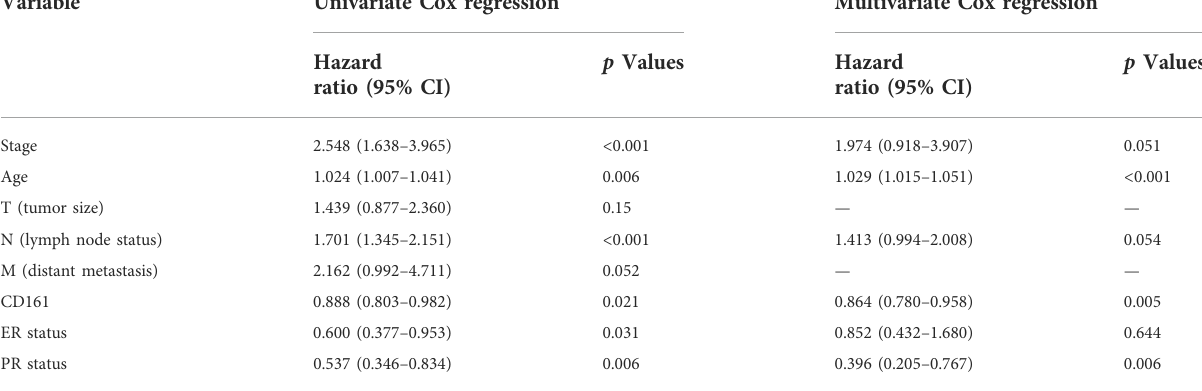
TABLE 2 Univariate Cox analysis and multivariate Cox analysis for OS.